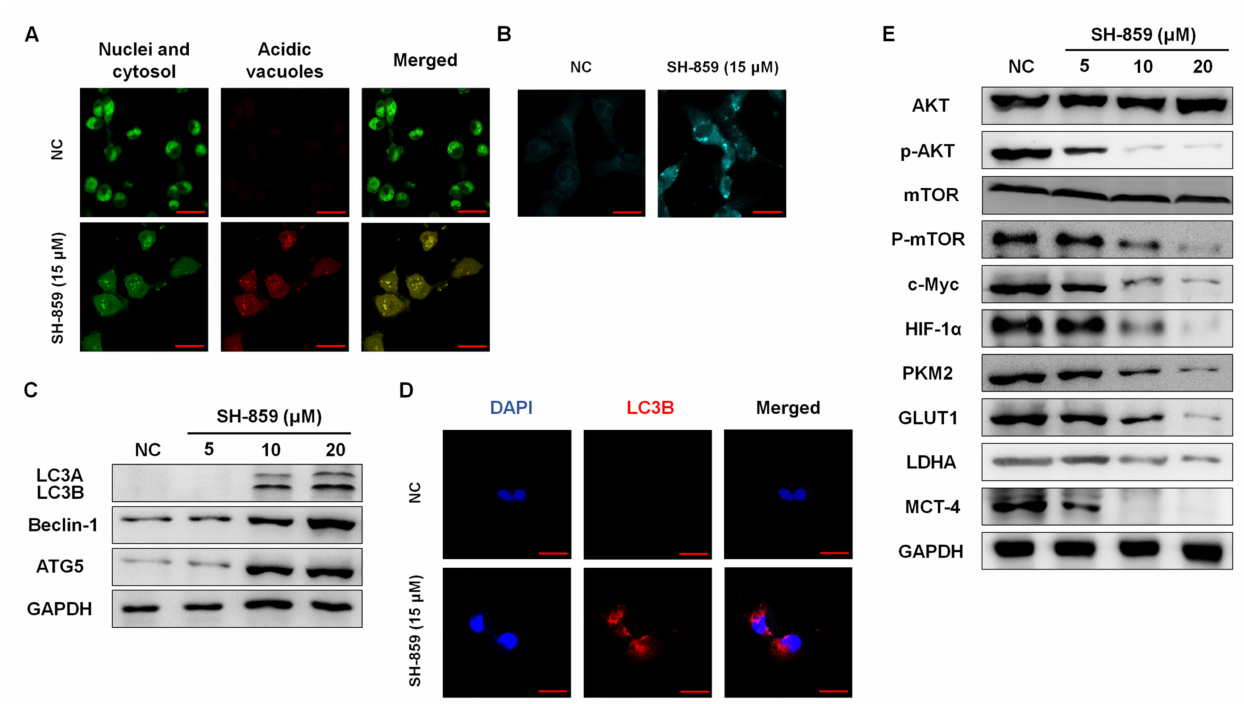
Figure 3. Evaluation of autophagy induction and various signaling pathways after SH-859 (15 µ M) treatment for 48 h. ( A ) 786-O cells were treated with SH-859 (15 µ M) and stained with acridine orange (1 µ g / mL). The formation of acidic vesicular organelles was examined under the confocal microscope. Fluorescent green staining in the cytoplasm and nucleus and fluorescent red or orange-red staining of autophagic vacuoles was detected. ( B ) Examination of autolysosome development with MDC staining. 786-O cells were treated, stained with MDC (50 µ M), and inspected using confocal microscopy. Scale bars indicate 50 µ m. ( C ) Immunoblot analysis of autophagy regulatory proteins in 786-O cells. Western blotting of whole-cell lysates was performed using antibodies specific for light chain 3-I / II (LC3-I / II), ATG5, and Beclin 1. GAPDH was used as an internal loading control. Representative blots are shown. ( D ) Immunofluorescence analysis was performed to evaluate the expression of light chain 3B (LC3B) after SH-859 (15 µ M) treatment. Higher LC3B expression (indicated by red fluorescence) was observed in SH-859-treated cells than in normal control (untreated 786-O cells). DAPI was used for nuclear staining. Goat anti-mouse IgG (H + L) cross-adsorbed secondary antibody Rhodamine Red-X was used to detect LC3B. ( E ) Expression levels of proteins associated with various signaling pathways after SH-859 treatment. Cells were treated with SH-859 and Western blotting was performed to examine the expression pattern of signaling pathway proteins. Representative blots are shown. Representative results from three independent experiments ( n = 3) have been shown. NC: normal control (untreated 786-O